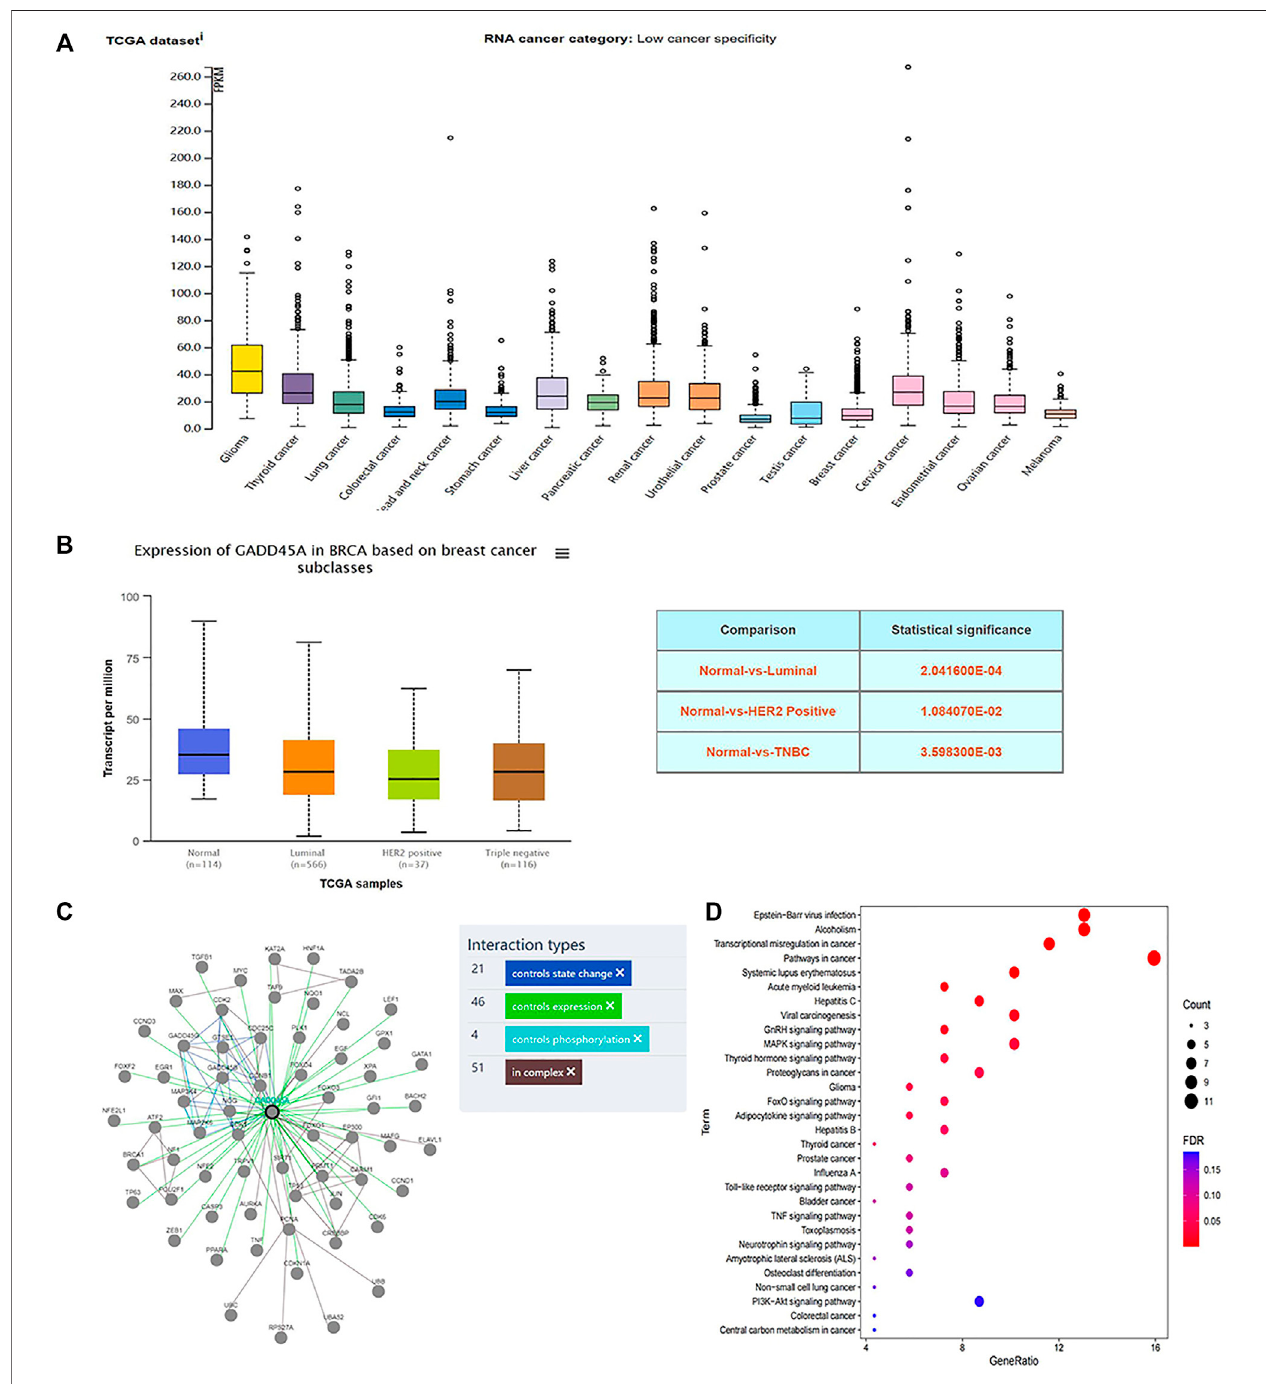
FIGURE 7 | GADD45A is expressed at a low level in TNBC. (A) GADD45A expression in different types of cancer tissues. (B) GADD45A expression in different types of breast cancer tissues and normal tissues. (C) GADD45A is interacted with multiple genes. (D) KEGG annotation classi fi cation statistics of GADD45A- related